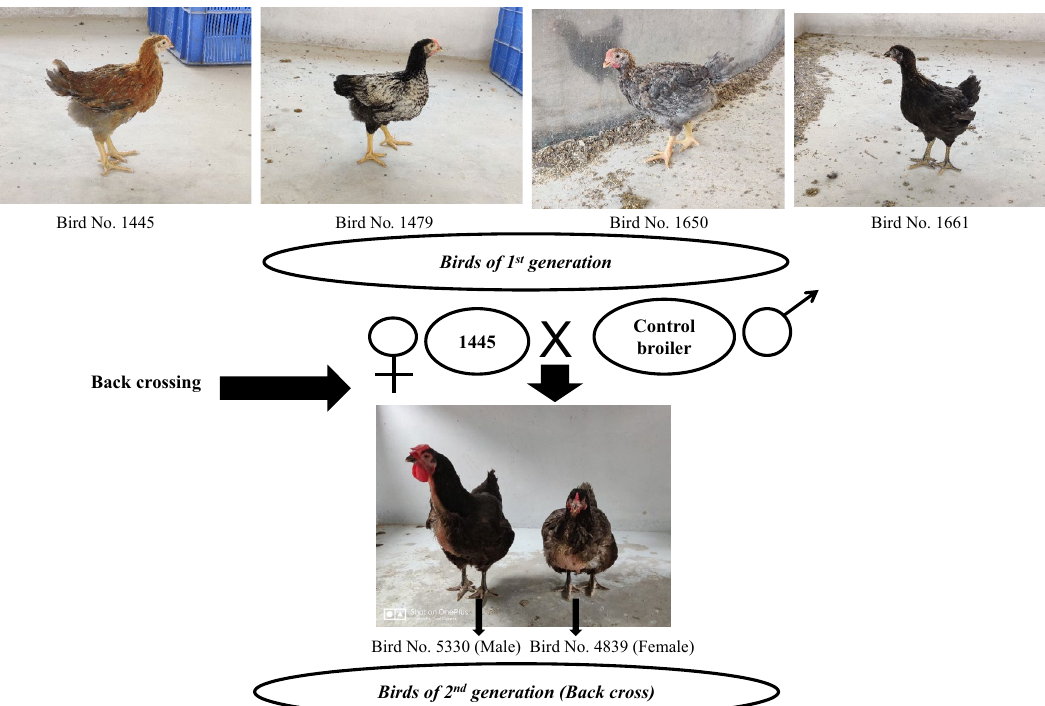
Figure 3. Transgenic birds developed at 1st and 2nd generation. At 1st generation, all the birds were female. At 1st generation, bird No. 1445: ACACA shRNA3; 1479: ACACA shRNA4; 1650: SREBP shRNA2 and 1661: SREBP shRNA2 were produced. Female transgenic birds of 1st generation was back crossed with control broiler birds as male parents to produce back cross transgenic progenies carrying shRNA constructs. At 2nd generation, two positive transgenic birds for ACACA shRNA construct were obtained. At 2nd generation, bird No. 4839 is male and bird No. 5330 is